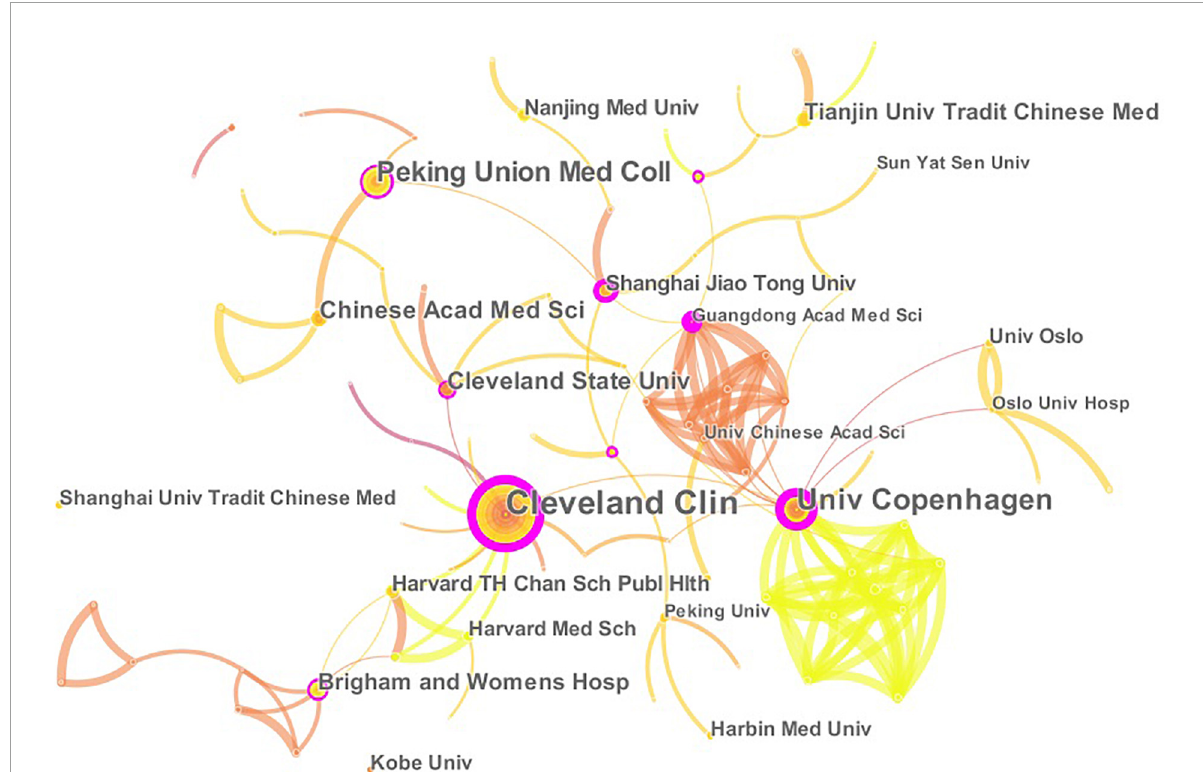
FIGURE5 The network of institutions engaged in the research about CHD and gut microbiota. In the networks, the larger the node was, the more contribution the institution had made to that field. The color of the line represents the time of first co-occurrence. The thicker the line is, the greater the connection strength is (calculation method based on cosine).